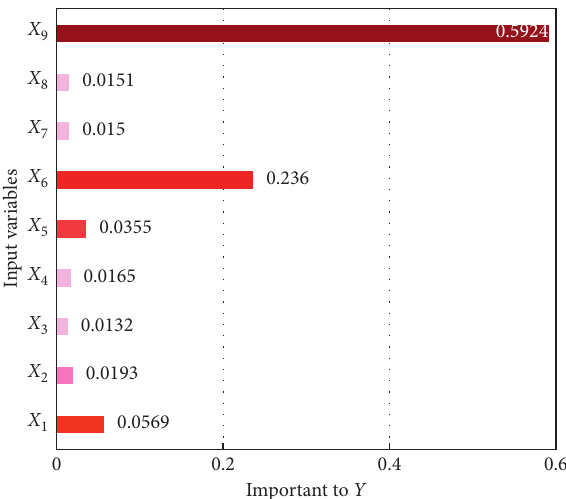
Figure 2: Bar chart of the correlations between the nine input features and output Y